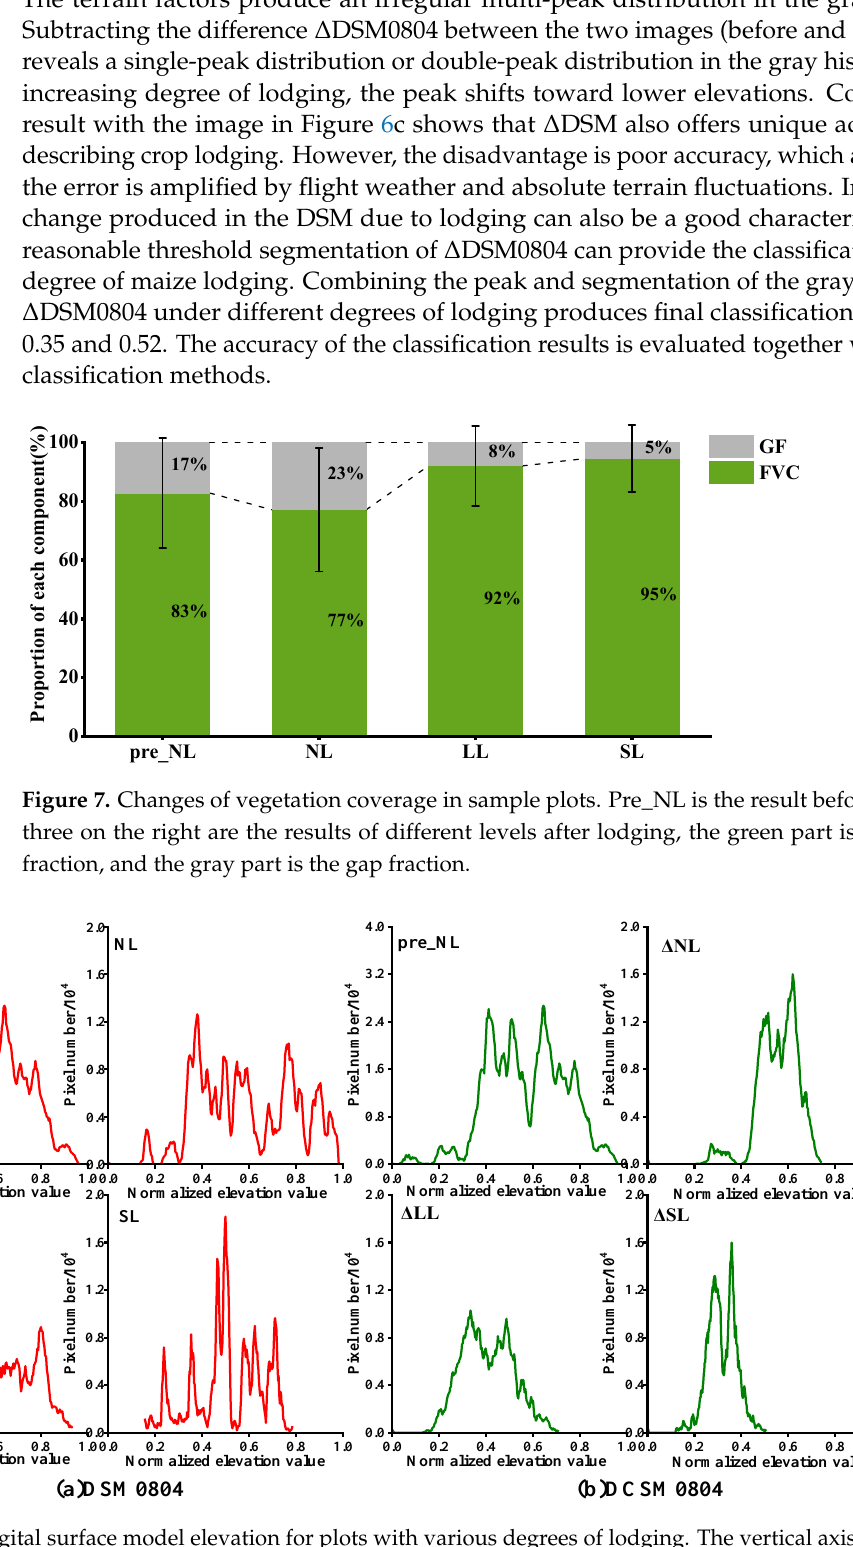
for the different degrees of lodging (Figure 9 ). The number of pixels in the red, green, and blue bands from the NL plot is basically the same before and after lodging (Figure 9a,b). For SL, the peak value of the blue band is lower than the red band, and the peak value of the red band is much lower than the green band. With increasing degree of lodging, the peaks of the three bands shift to higher gray values; that is, the reflectivity changes, and the gray value of the green band increases significantly. According to the histogram of the mean change for the different degrees of lodging (Figure 10 ), the reflectivity of each band increases by 8.49 – 17.95% for moderate lodging, and by 21.91 – 38.99% for SL.